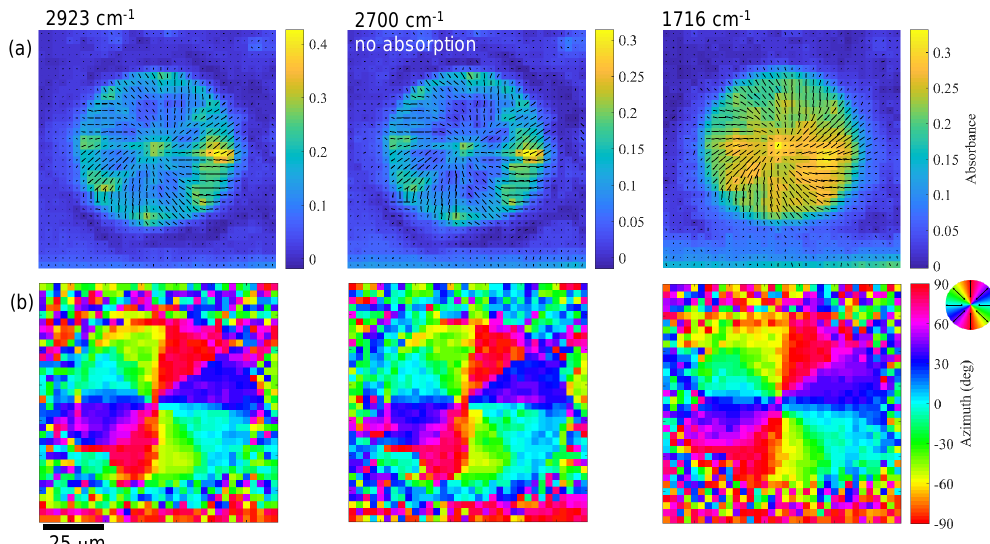
Figure 5. ( a ) Orientation images at different wavenumbers: at the absorption bands and at the wavenumber of 2700 cm − 1 where there was no absorption peak. The orientation azimuth angle θ (cid:48) was measured from the fit taken at four θ angles, and the length of the black line represents the orientation strength defined by the amplitude of the min-max absorbance A max − A min [12]. ( b ) Orientation azimuth at the three wavenumbers. Orientation azimuth direction is the same as the polymer structure